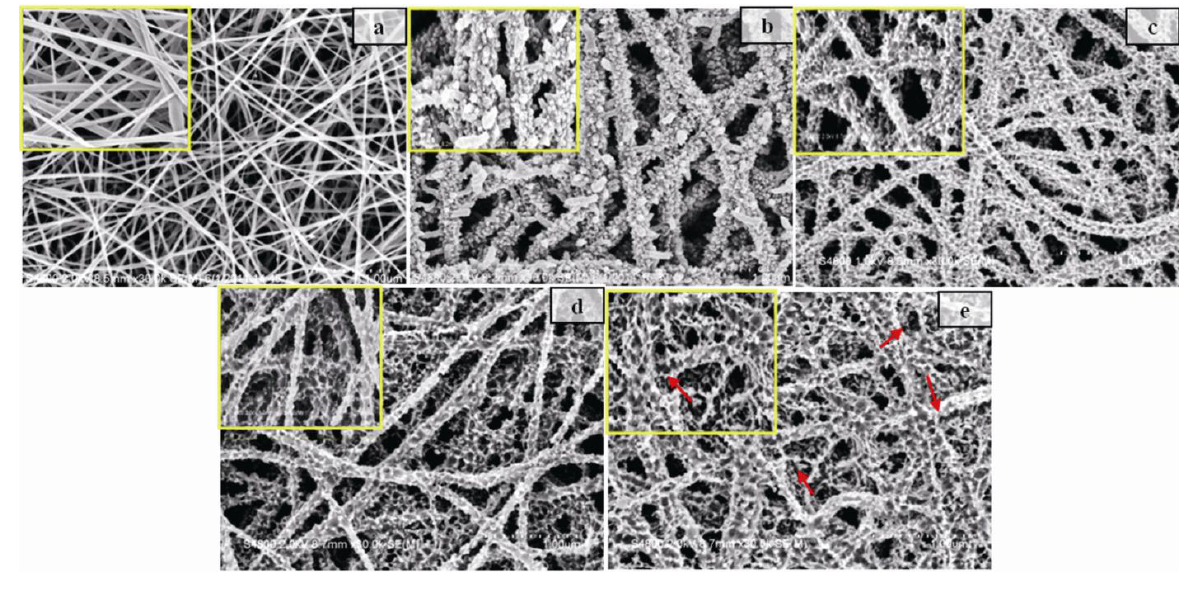
Figure 4. SEM image of ( a ) PA6 nanofibers; ( b ) PANI/PA6 nanofibers; ( c ) PANI/PA6 nanofibers sputtered for 30 min; ( d ) TiO ( e ) TiO -PANI/PA6nanofibers sputtered for 90 2